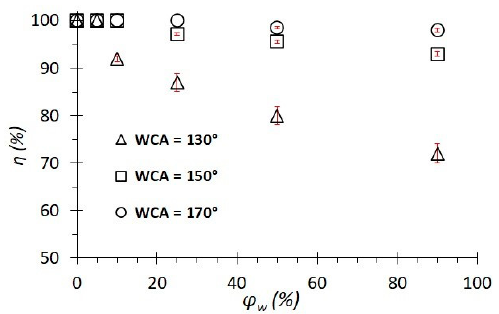
Figure 3. Dependence of the separation efficiency on the water concentration in the emulsion for coatings with different wetting contact angles.